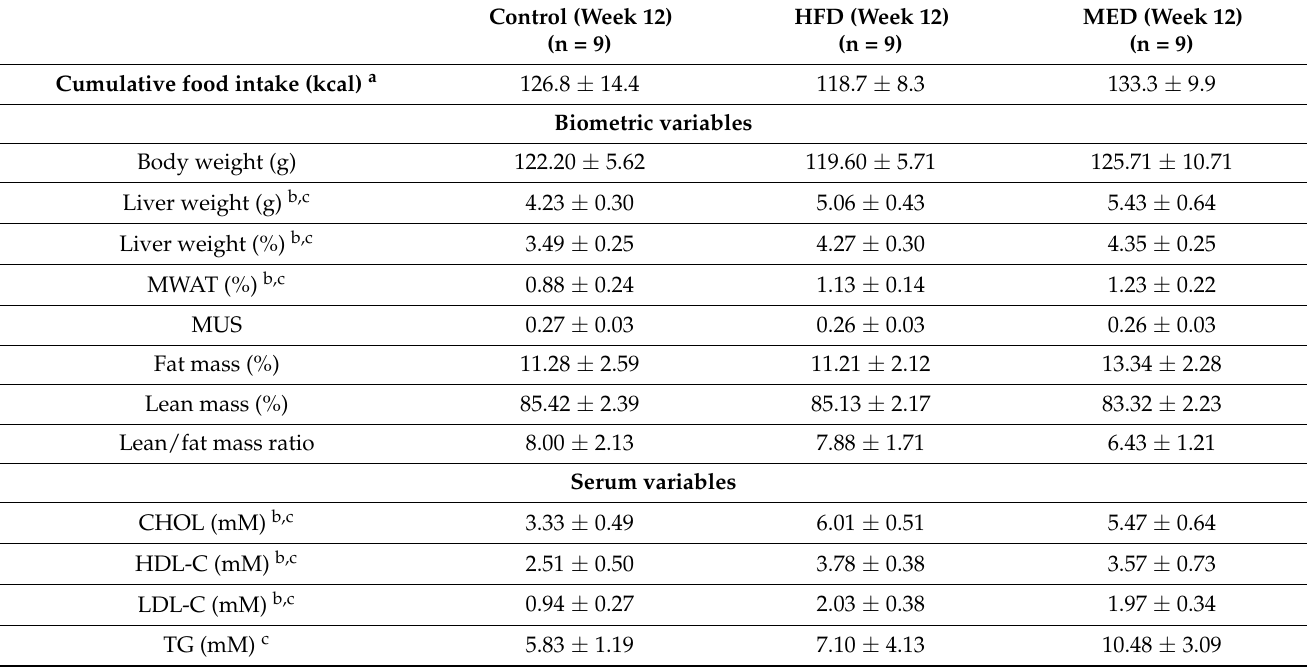
Table 2. Effects of HFD and MED on food intake and biometric and serum variables at the end of